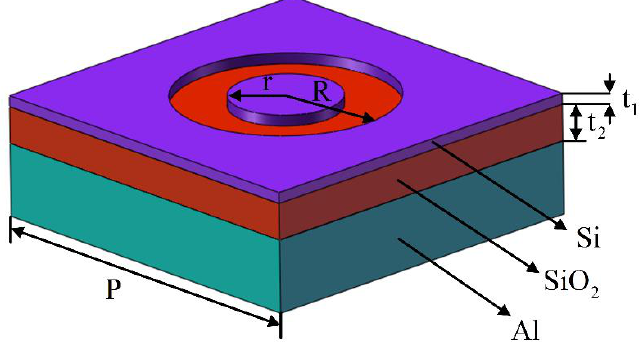
Figure 1. The elementary unit cell of the proposed structure.